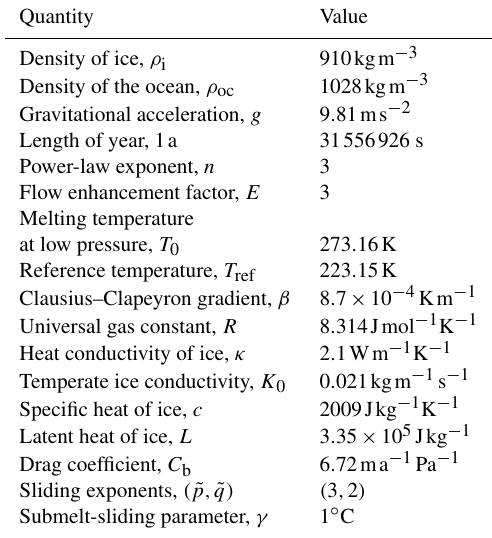
Table A1. Physical parameters used for ISSM.